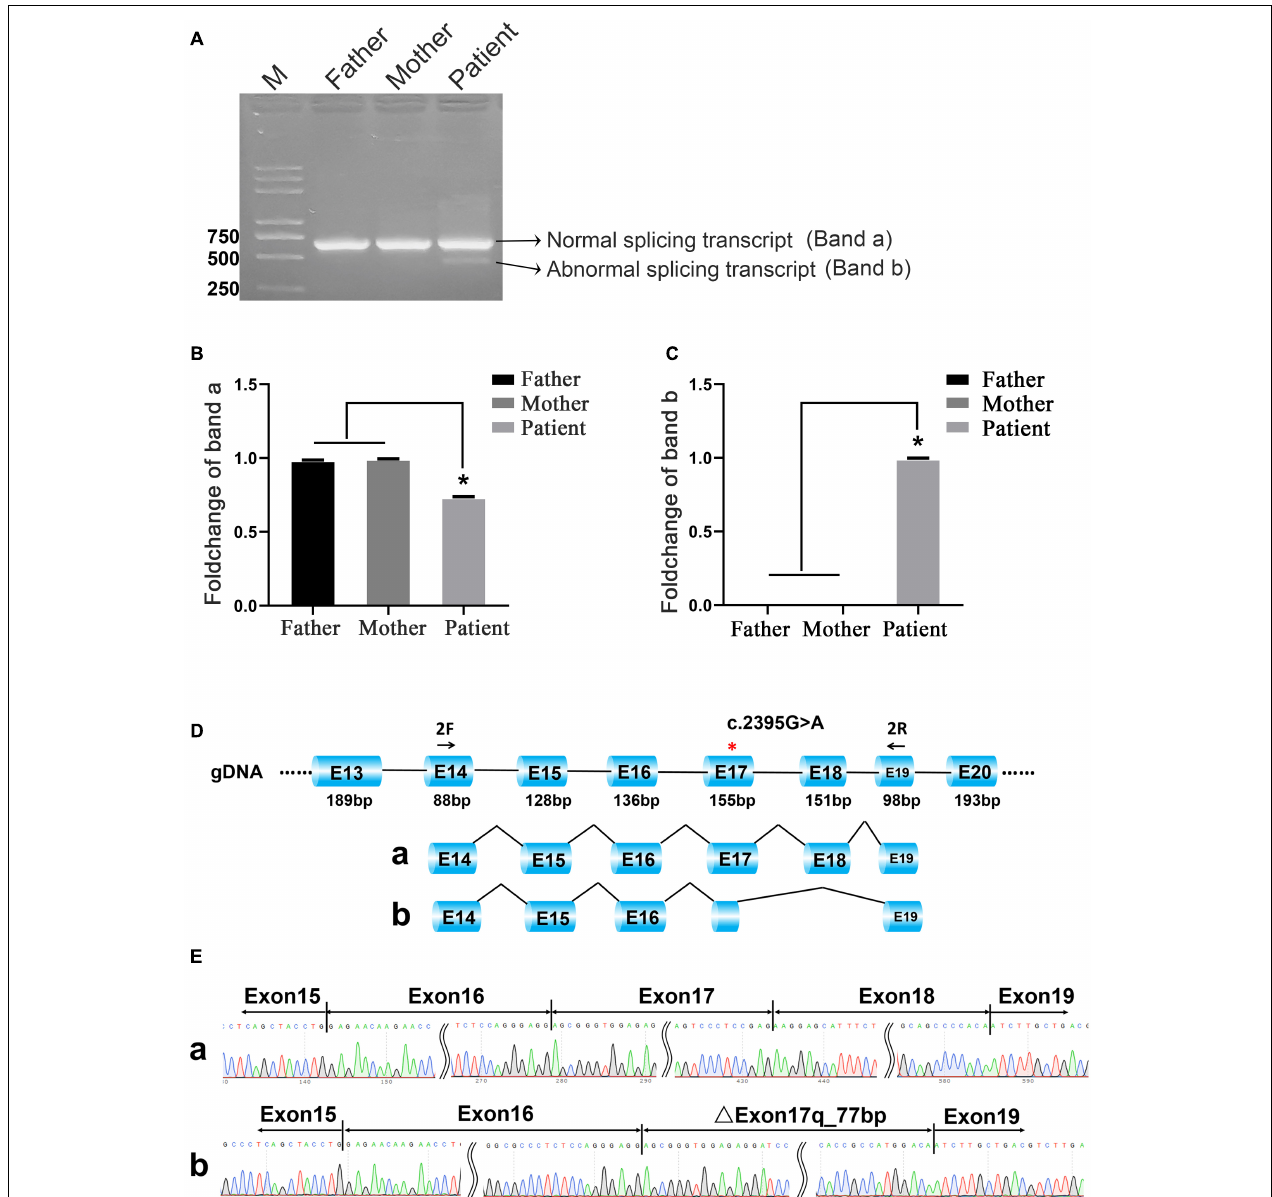
FIGURE 2 | C.2395G > A mutation caused different splicing patterns in the family. (A) Agarose gel electrophoresis. Band a and band b represent normal splicing and abnormal splicing, respectively. M means the DNA marker. (B) The qRT-PCR results of band a; * p < 0.05. (C) The qRT-PCR results of band b; * p < 0.05. (D,E) The schematic representation and the Sanger sequencing results of the two different